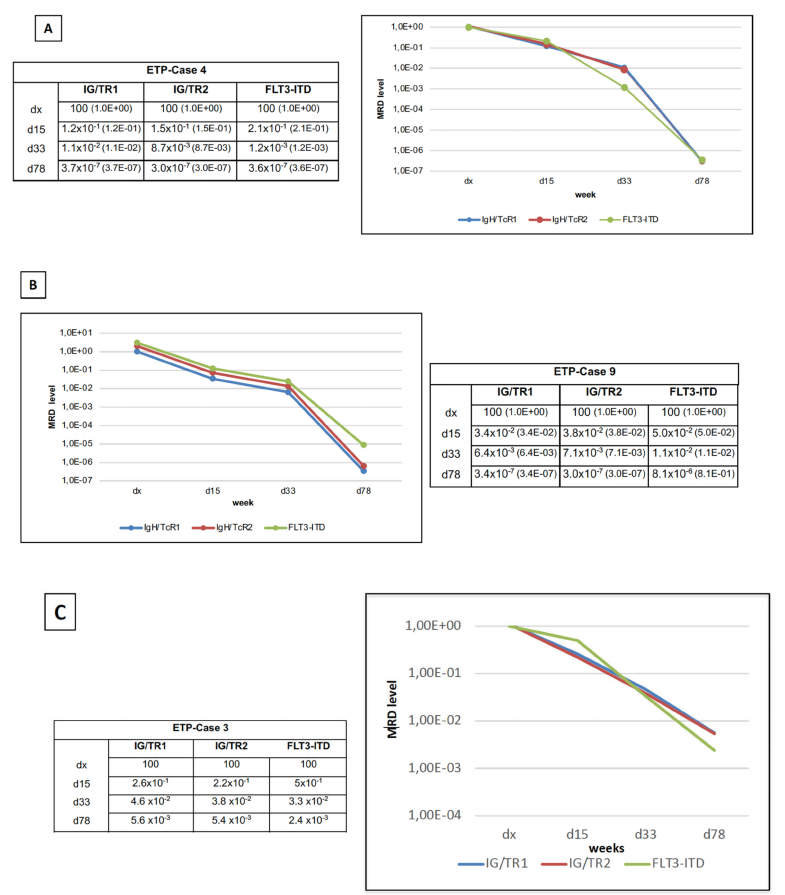
Figure 1. Diagrams of MRD levels in three children with ETP-ALL, comparing the IG/TR with FLT3-ITD as markers of detection. Analyses were performed during the induction phase, as well as at day15, day33, and day78, respectively. ( A , B ) MRD levels of patients in ETP-Case 4 and ETP-Case 9 almost completely overlapped in all three consecutive time points. In ETP-Case 3 ( C ) the kinetic of MRD reduction was detected by all three markers, although the Quantitative Range did not reach the 1 × 10 − 4